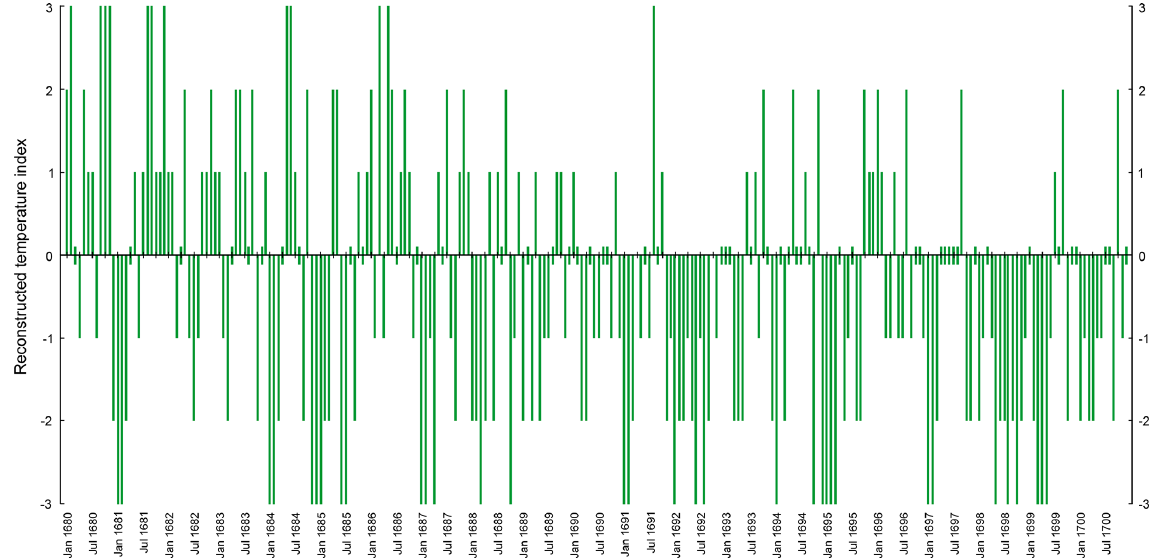
Figure 1. Monthly seven-point temperature indices for the Swiss Plateau (1680–1700CE), reconstructed using the Pfister index approach (data from Pfister, 1998). Zero values for specific months are indicated by a small green bar.